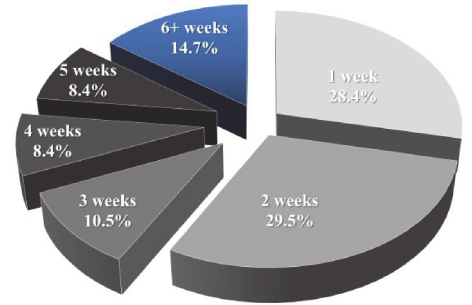
Figure 5. Distribution of issues according to coordination time